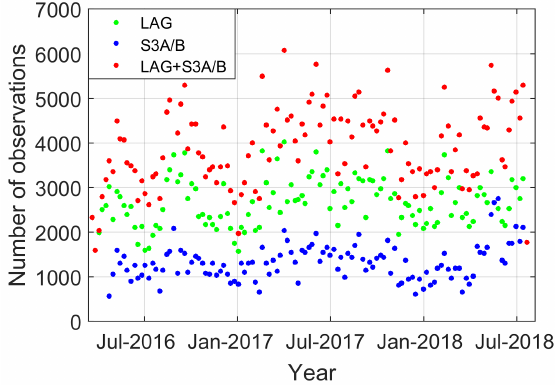
Figure 1. Satellite Laser Ranging (SLR) observations to S3A/B and LAG in 7-day